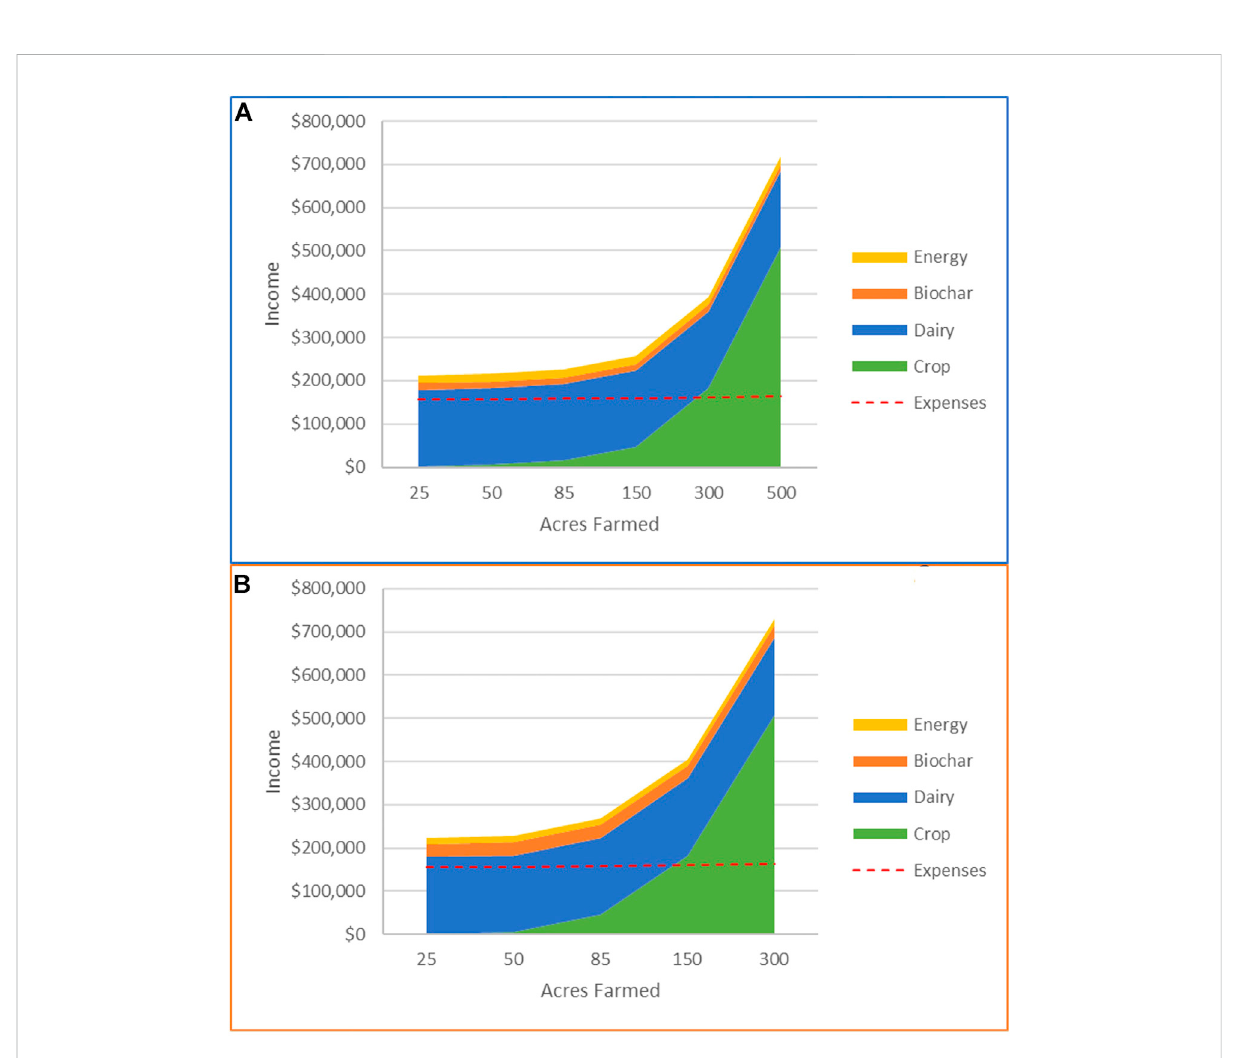
FIGURE 8 Components of Monthly Income Using Gasi fi cation, (A) and Pyrolysis (B) acres varied.